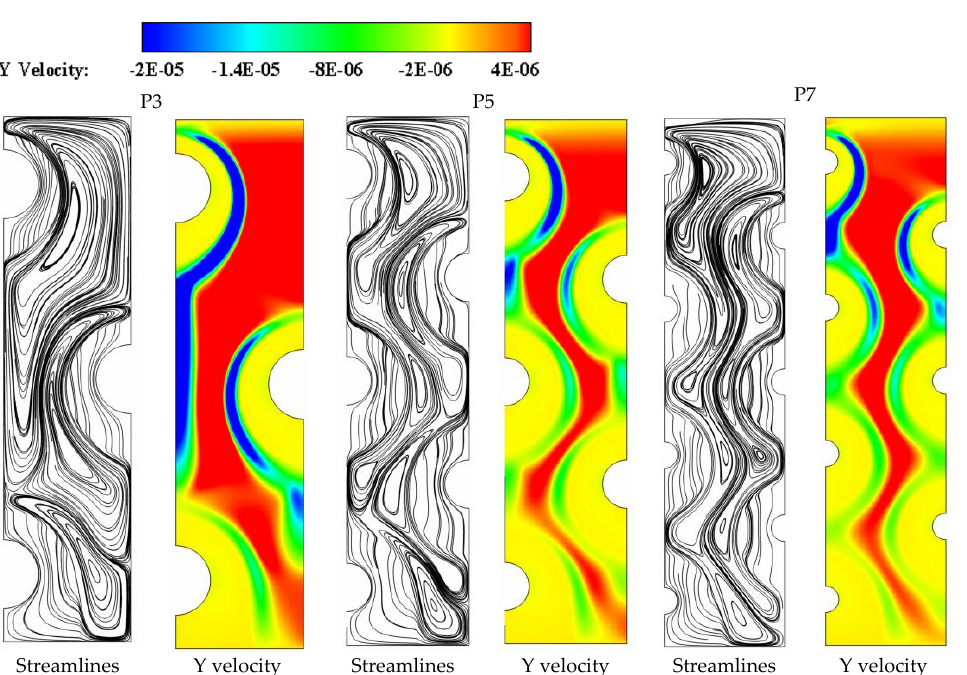
Figure 6. The velocity field and streamlines for three different HTF-tube arrangements of P3, P5, and P7 after 8 h of solidification.